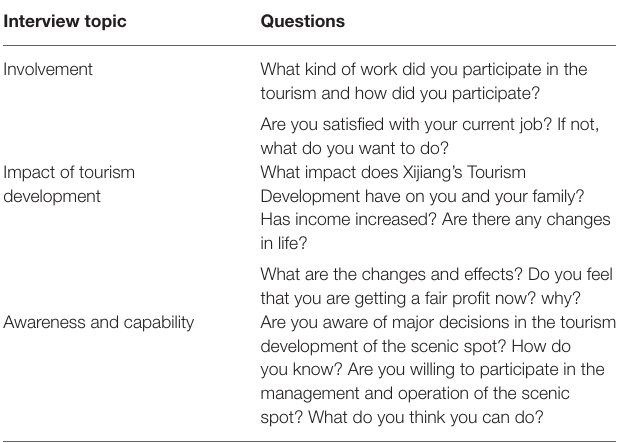
TABLE 2 | In-depth interview